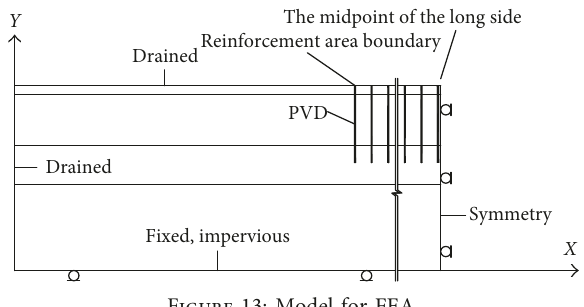
Figure 13: Model for